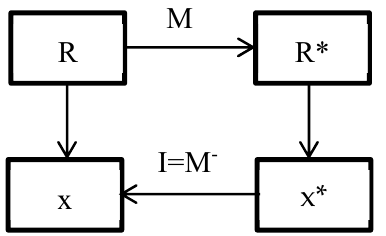
Figure 2. The relationship structure of RMI